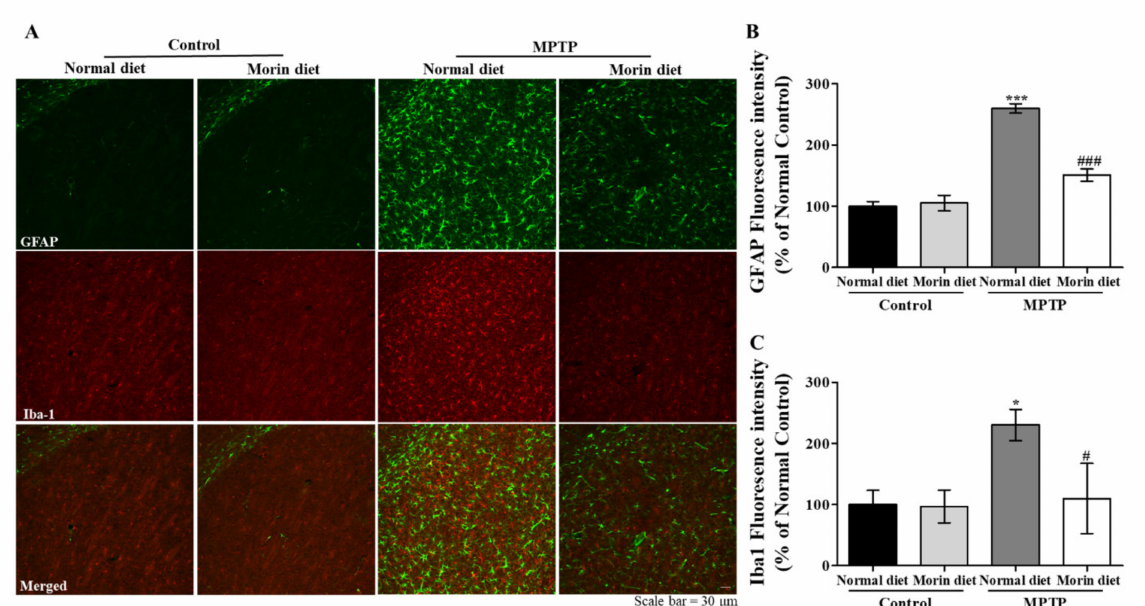
Figure 4. Morin attenuated glial activation in our PD model. Double immunohistochemistry was performed using antibodies against GFAP (an astrocyte marker) and Iba-1 (a microglial marker) to evaluate neuroinflammation. Increased astroglial activations were observed in the MPTP normal diet, but these activations were suppressed by dietary morin. ( A ) Striatum. ( B ) Quantitative analysis of GFAP (green) fluorescence intensities. Data are expressed as means ± SEMs. *** p < 0.001 vs. control normal diet, ### p < 0.001 vs. MPTP normal diet. ( C ) Quantitative analysis of Iba-1 (red) fluorescence intensities. Data are expressed as means ± SEMs. * p < 0.05 vs. control normal diet, # p < 0.05 vs. MPTP normal